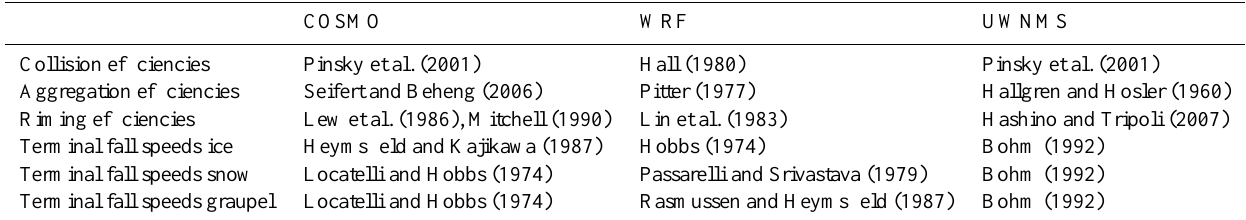
Table 1. Details of the microphysical parametrisations used in the